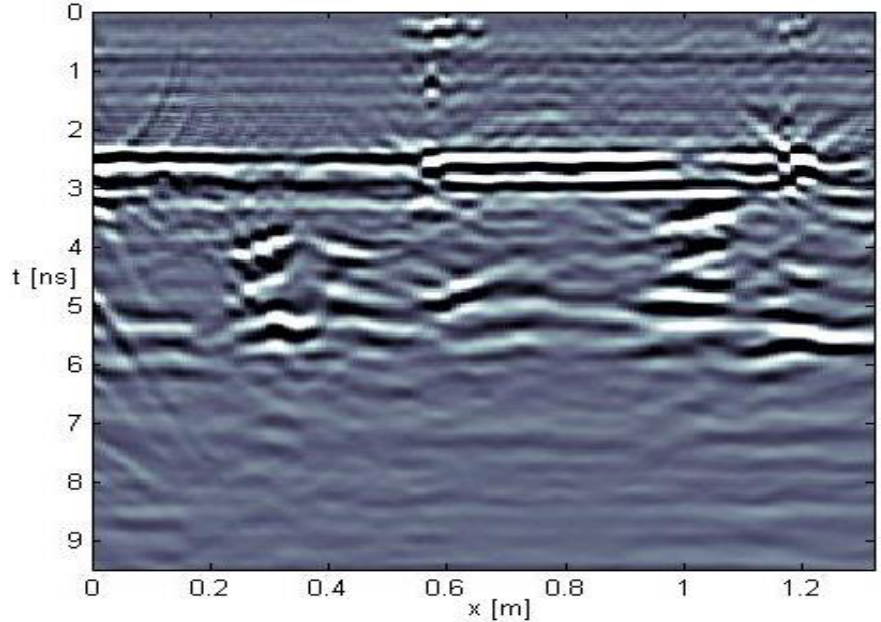
Figure 6. Joined migration with horizontal variation of the propagation velocity, merging the results of Figure 4.